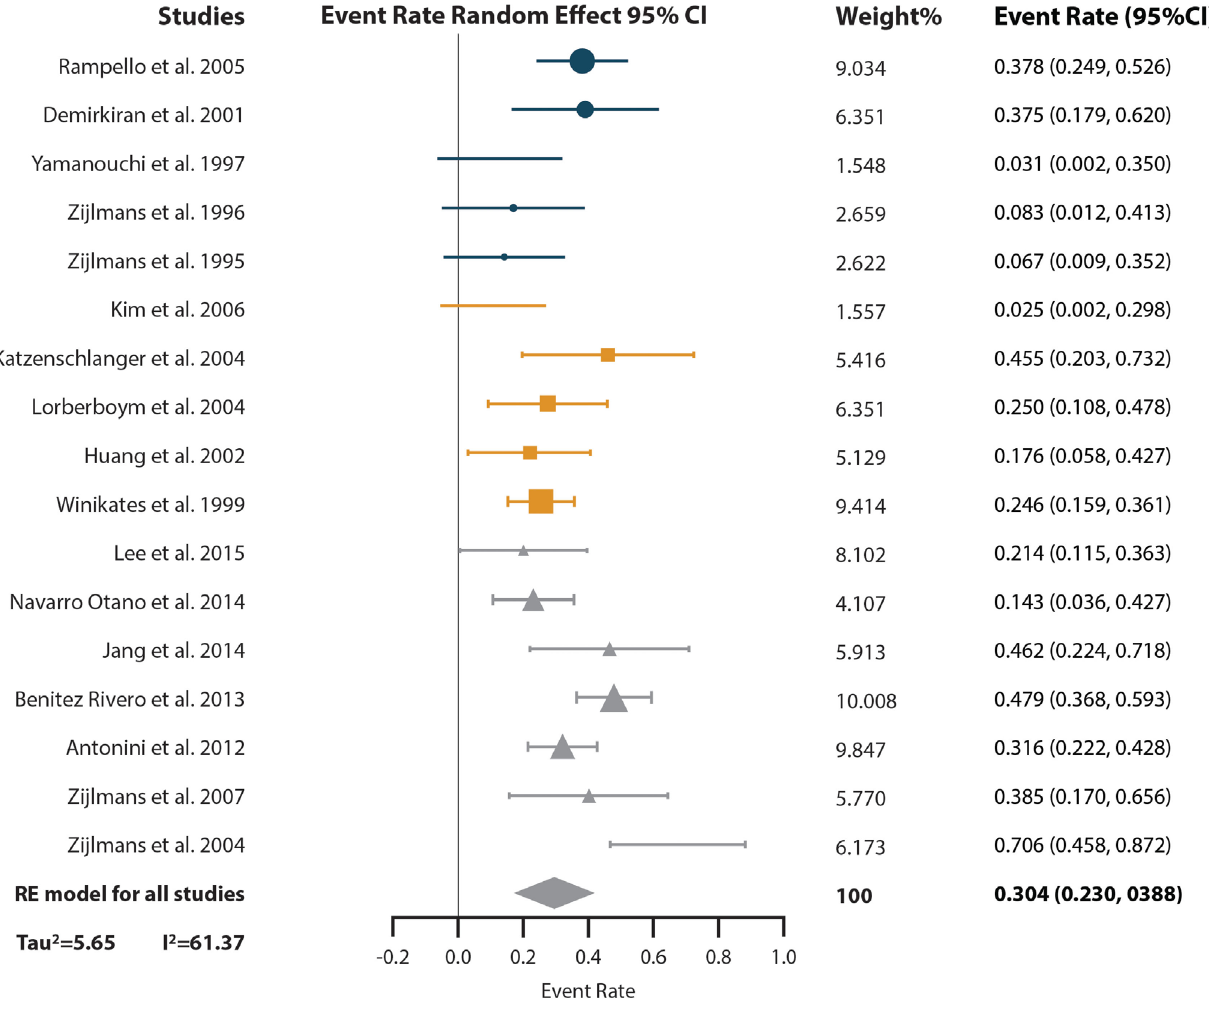
FigURe 3 | Pooled random effect event rate and 95% confidence interval (CI) for the prevalence of levodopa response in vascular parkinsonism subjects. Circles represent studies with the “Other” diagnostic criteria, squares represent studies with the “Winikates’” diagnostic criteria, and triangles represent “Zijlmans’ ” diagnostic criteria. Size of the geometrical figures is proportional to their respective relative weight. RE, random